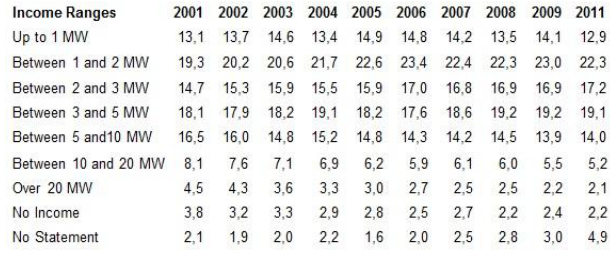
TABLE 2 – Families per monthly household income